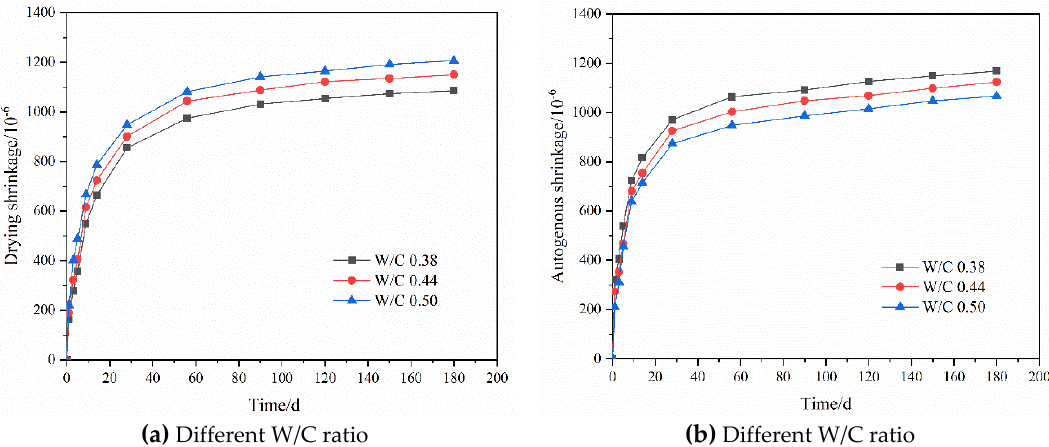
Figure 3. Effect of the W/C on the shrinkage of mortar: ( a ) Drying shrinkage; ( b ) autogenous shrinkage.